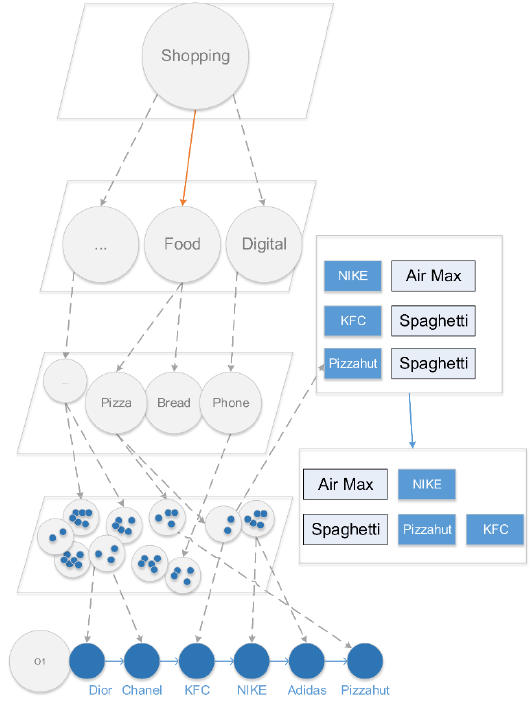
Figure 11. Multi-granularity semantic hierarchy tree.